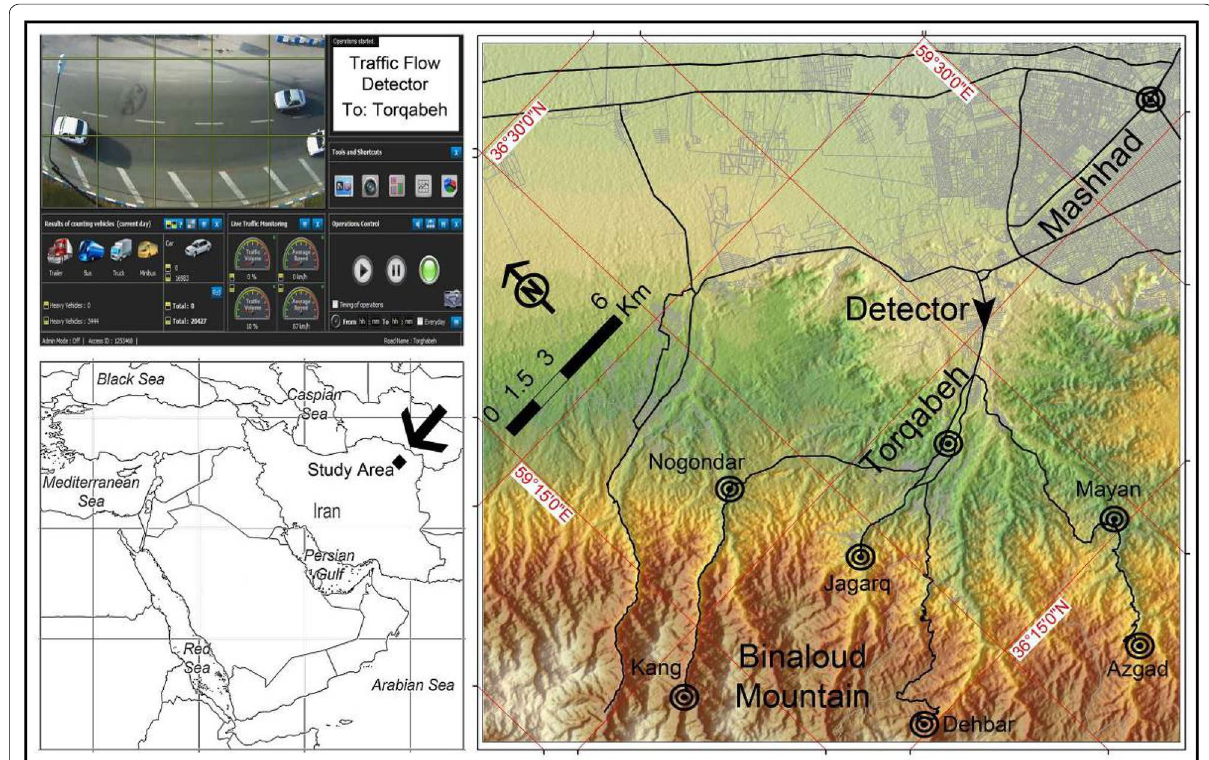
Fig. 1 General position and geographical situation of the study area including the location of traffic flow detector of departing road from Mashhad to Torqabeh